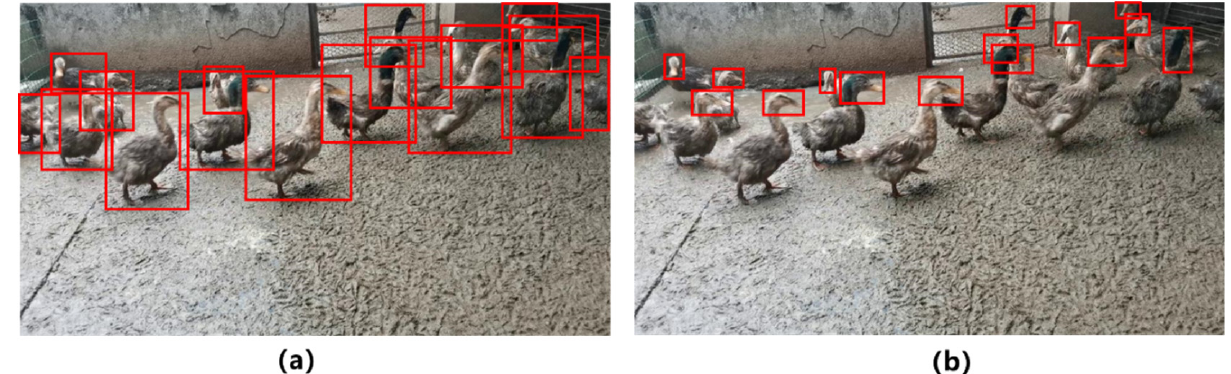
Figure 2. ( a ) Example of data annotation of the whole body of hemp ducks; ( b ) example of data annotation of hemp ducks with only the head